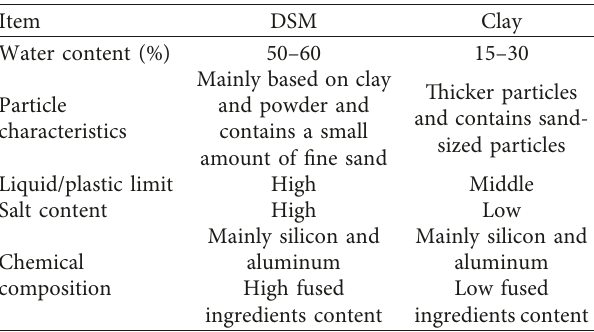
Table 3: The properties of DSM and clay materials.